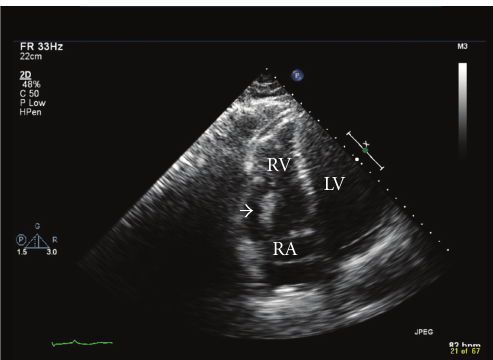
Figure 1: Transthoracic echocardiography showing a large right atrial thrombus (white arrow) extending into the right ventricle.